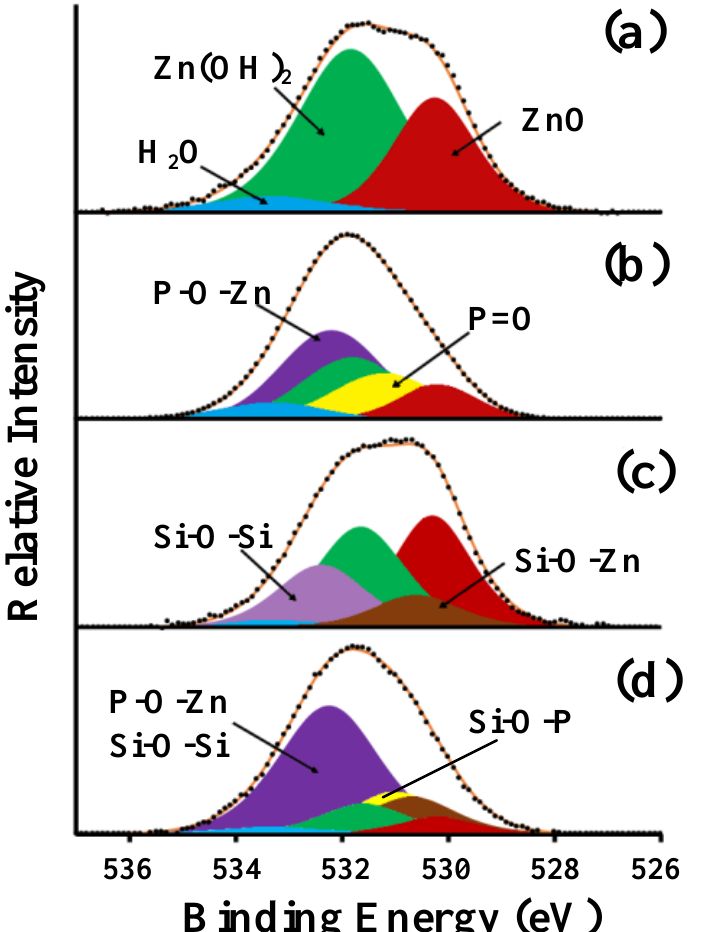
Figure 7. O1 s spectra of zinc samples with “smooth” surface (Type 1) ( a ) before and after treatment in solutions of ( b ) 2.5 mM SDDP, ( c ) 10.0 mM OTES, ( d ) 2.5 mM SDDP/10.0 mM OTES.